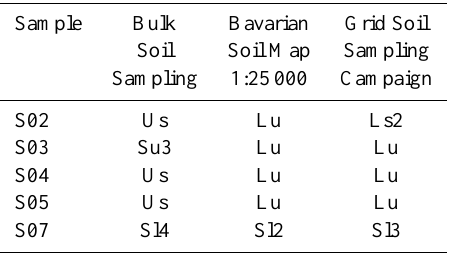
Table 6. Saturated hydraulic conductivity k s according to BGR (2005) and Scheinost et al. (1997).